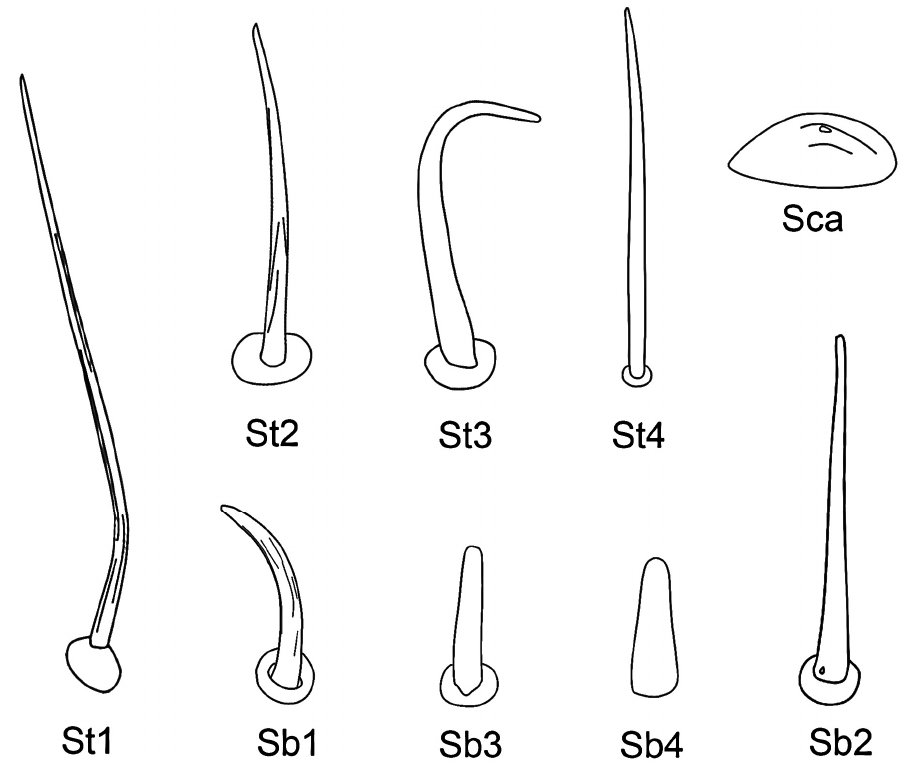
Figure 2. Diagrams of different types of sensilla on mouthparts of C. nigrescens . Sb1, sensilla basiconica I; Sb2, sensilla basiconica II; Sb3, sensilla basiconica III; Sb4, sensilla basiconica IV; Sca,